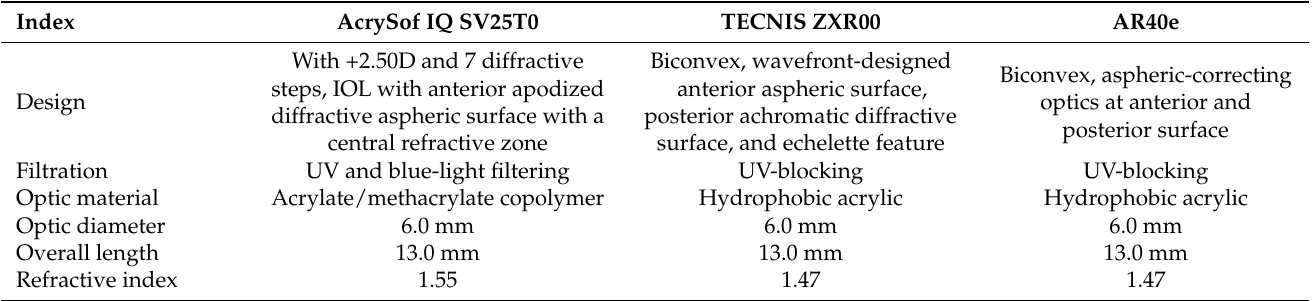
Table 2. Comparison between bifocal Restor +2.5 D (AcrySof IQ SV25T0), EDOF Symfony (TECNIS ZXR00) and monofocal Sensar (AR40e).